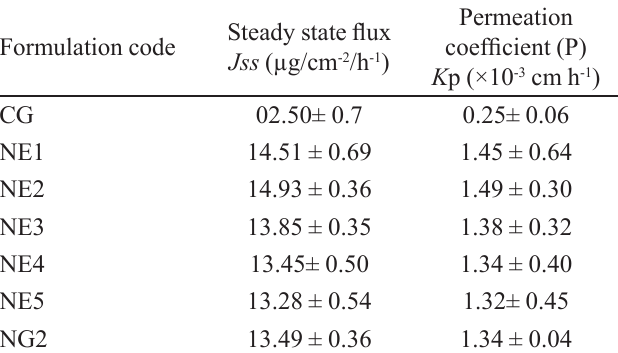
TABLE III - Permeability parameters for the different formulations